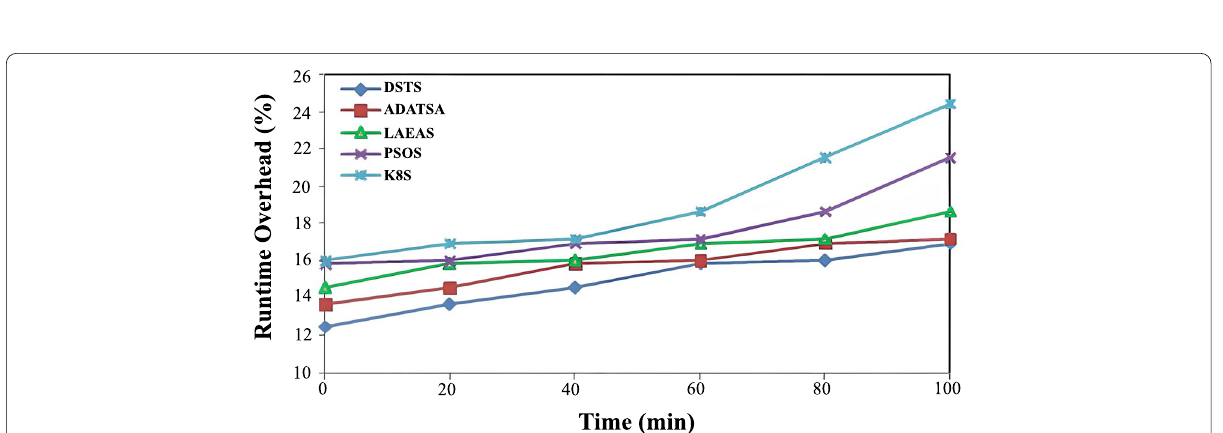
Fig. 14 Comparative analysis of runtime